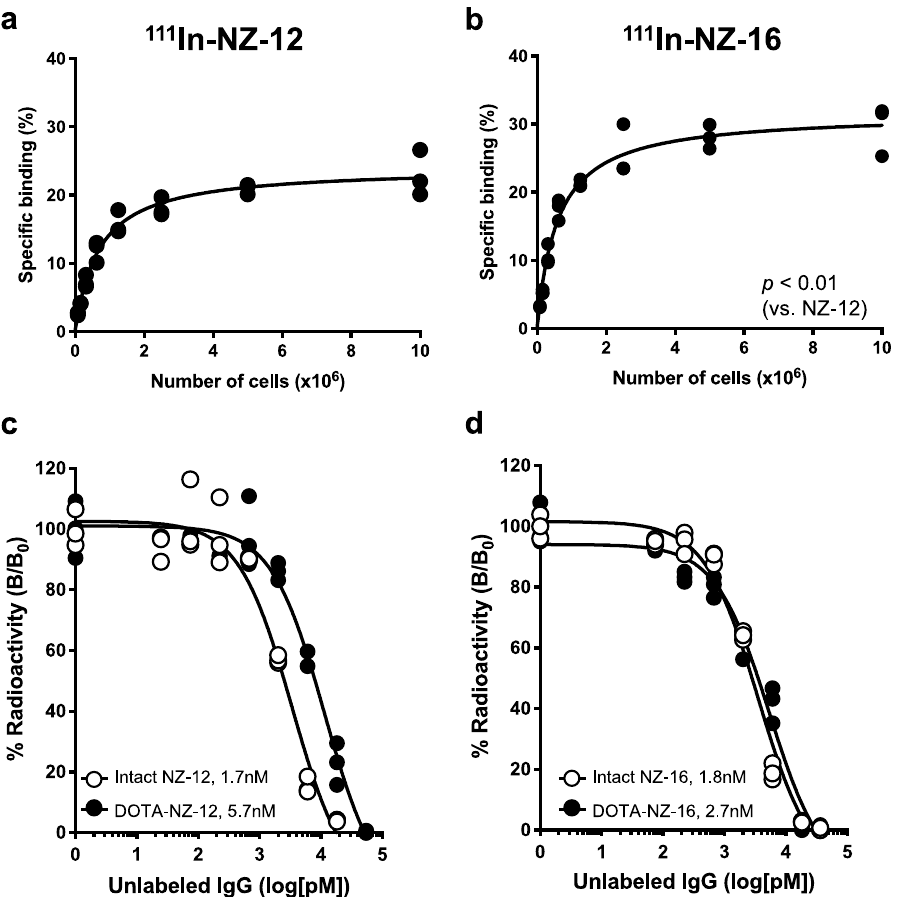
Figure 1. In vitro characterization of radiolabeled antibodies NZ-12 and NZ-16. ( a ) Cell binding assay of 111 In-labeled NZ-12 with H226 cells. ( b ) Cell binding assay of 111 In-labeled NZ-16 with H226 cells. ( c ) Competitive inhibition assay for intact NZ-12 (white circles) and DOTA-conjugated NZ-12 (black circles) with H226 cells. ( d ) Competitive inhibition assay for intact NZ-16 (white circles) and DOTA-conjugated NZ-16 (black circles) with H226